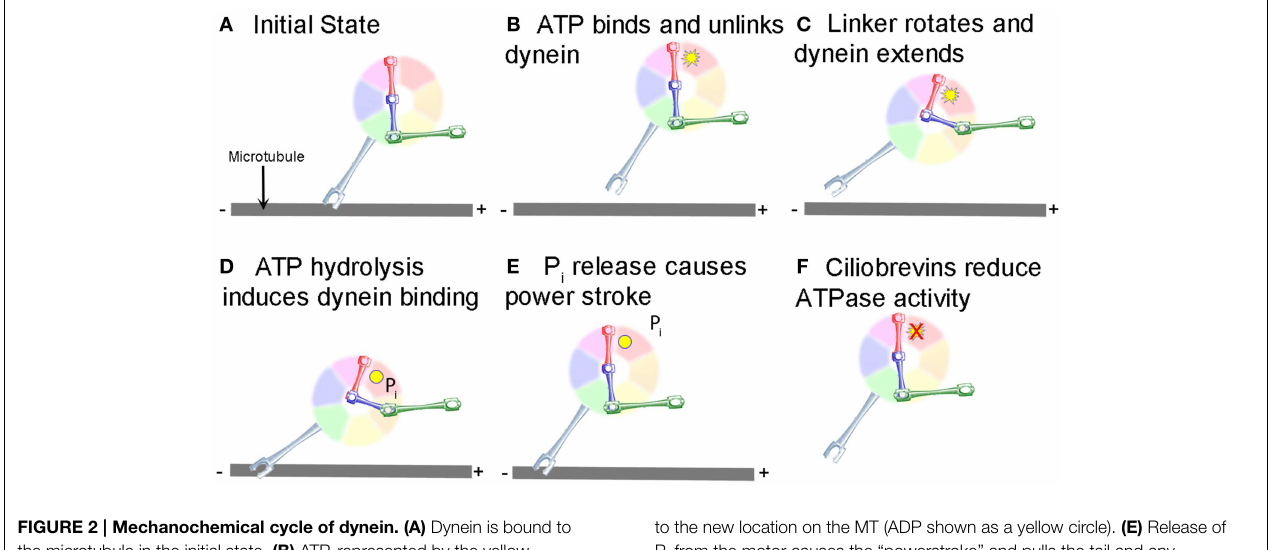
FIGURE 2 | Mechanochemical cycle of dynein. (A) Dynein is bound to the microtubule in the initial state. (B) ATP, represented by the yellow starburst, binds to the AAA + ATPase domain, causing the MTBD to release from the MT. (C) Unlinking of the stalk from the MT causes a conformational change in the linker, which rotates and extends the stalk closer to the minus end of the MT. (D) Hydrolysis of ATP to ADP.P i induces binding of the MTBD